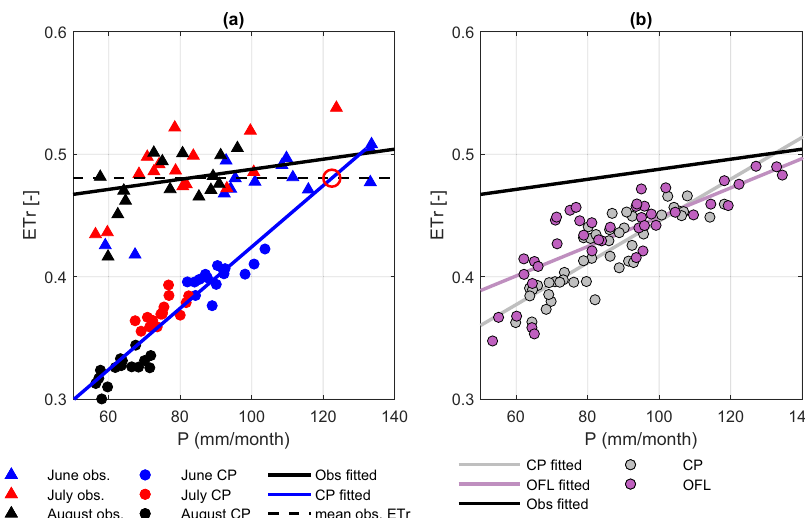
Fig. 2 Sensitivity of CMIP6-modeled ET to reduced precipitation. a Observed and CMIP6 (Coupled Model Intercomparison Project Phase 6) modeled CUS (central contiguous United States) monthly mean ETr (calculated as the ratio of evapotranspiration (ET) and net shortwave ration (Rs), or ET/Rs) as a function of monthly mean precipitation (P) during 2000 – 2014 June – July – August (JJA) periods. The large open red circle in ( a ) captures the intersection of the extrapolated CMIP6 regression line with the monthly mean-observed ETr line. Part ( b ) is same as (a) but for 3-model-averaged (EC-Earth3-Veg, IPSL- CM6A-LR and MIROC6) CMIP6 (denoted as CP) and CMIP6_OFL (CMIP6 off-line simulation, denoted as OFL) results. ET values are based on FluxCOM estimates; however, no qualitative change is found when a different ET reference is used instead (see Supplementary Fig.